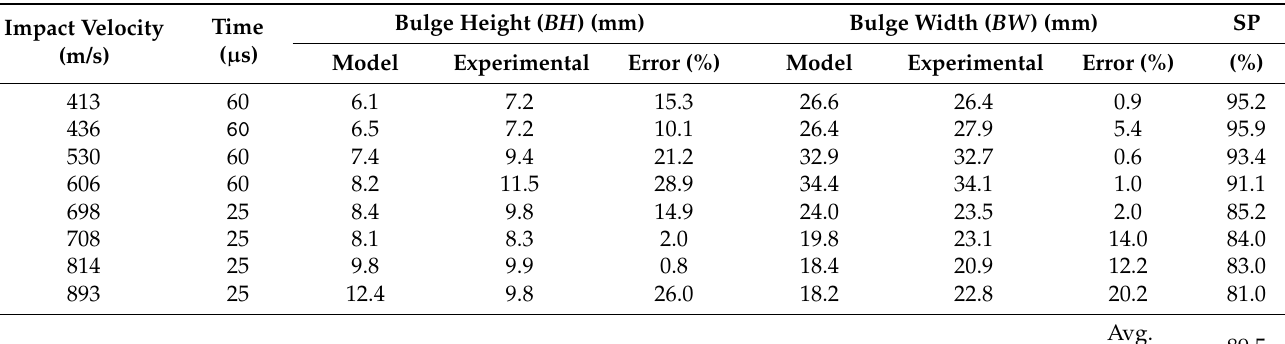
Table 7. Calibrated case’s ballistic simulation results (BH, BW) compared to the experimental results. Impact Velocity